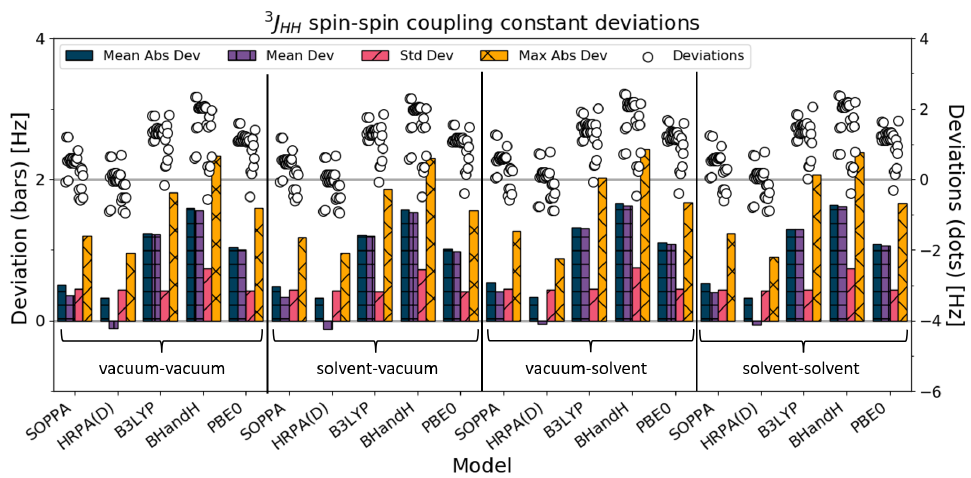
Figure 6. The statistics for the 3 J HH coupling constants excluding trans-1,2-dichlorocyclopentane SSCCs. Table 6. Statistical data for the 3 J HH SSCCs excluding the trans-1,2-dichlorocyclopentane SSCCs.